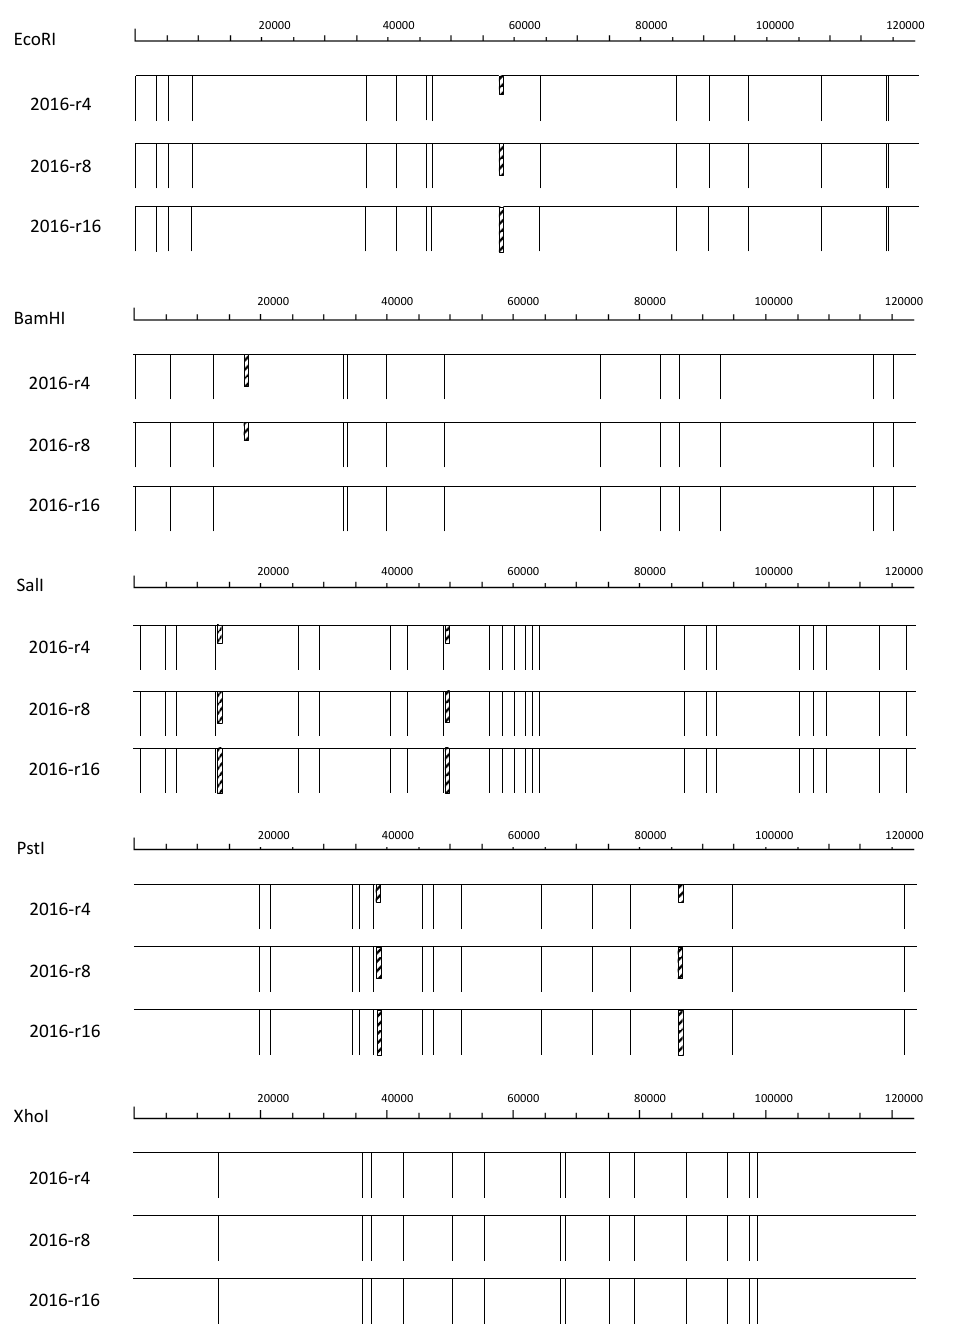
Figure 1. Graphical map of the genomes of CpGV isolates obtained after sequential amplification on resistant RGV larvae. The relative proportion of the variable restriction sites are represented by dashed rectangles. Their length is proportional to the relative abundance. The restriction sites shared by the three isolates are represented by lines of equal